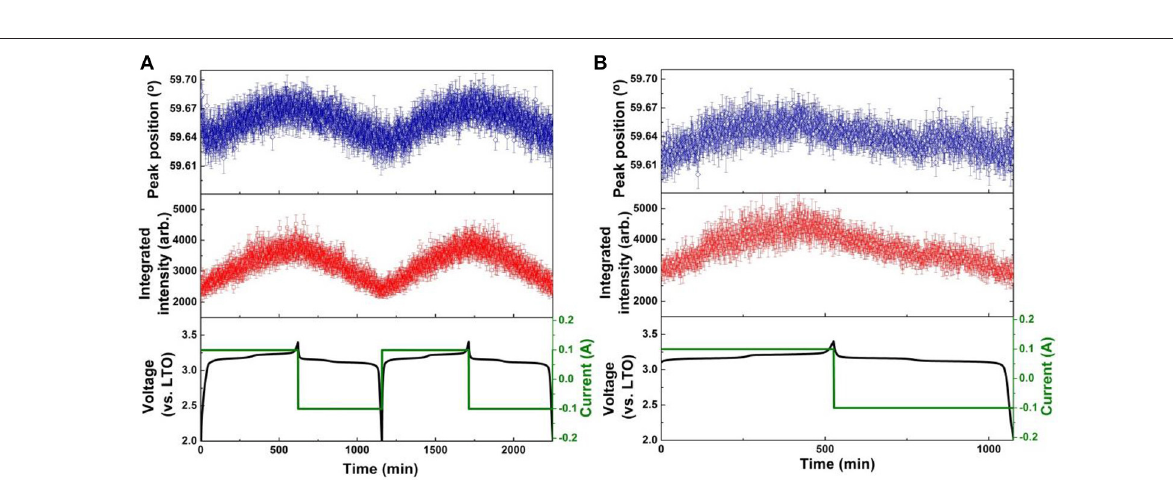
transitions are less marked, suggesting some decay of